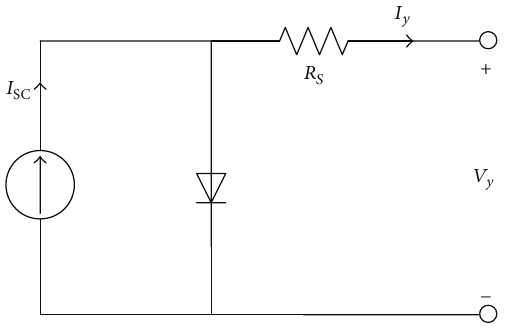
Figure 1: Simplified equivalent circuit model.